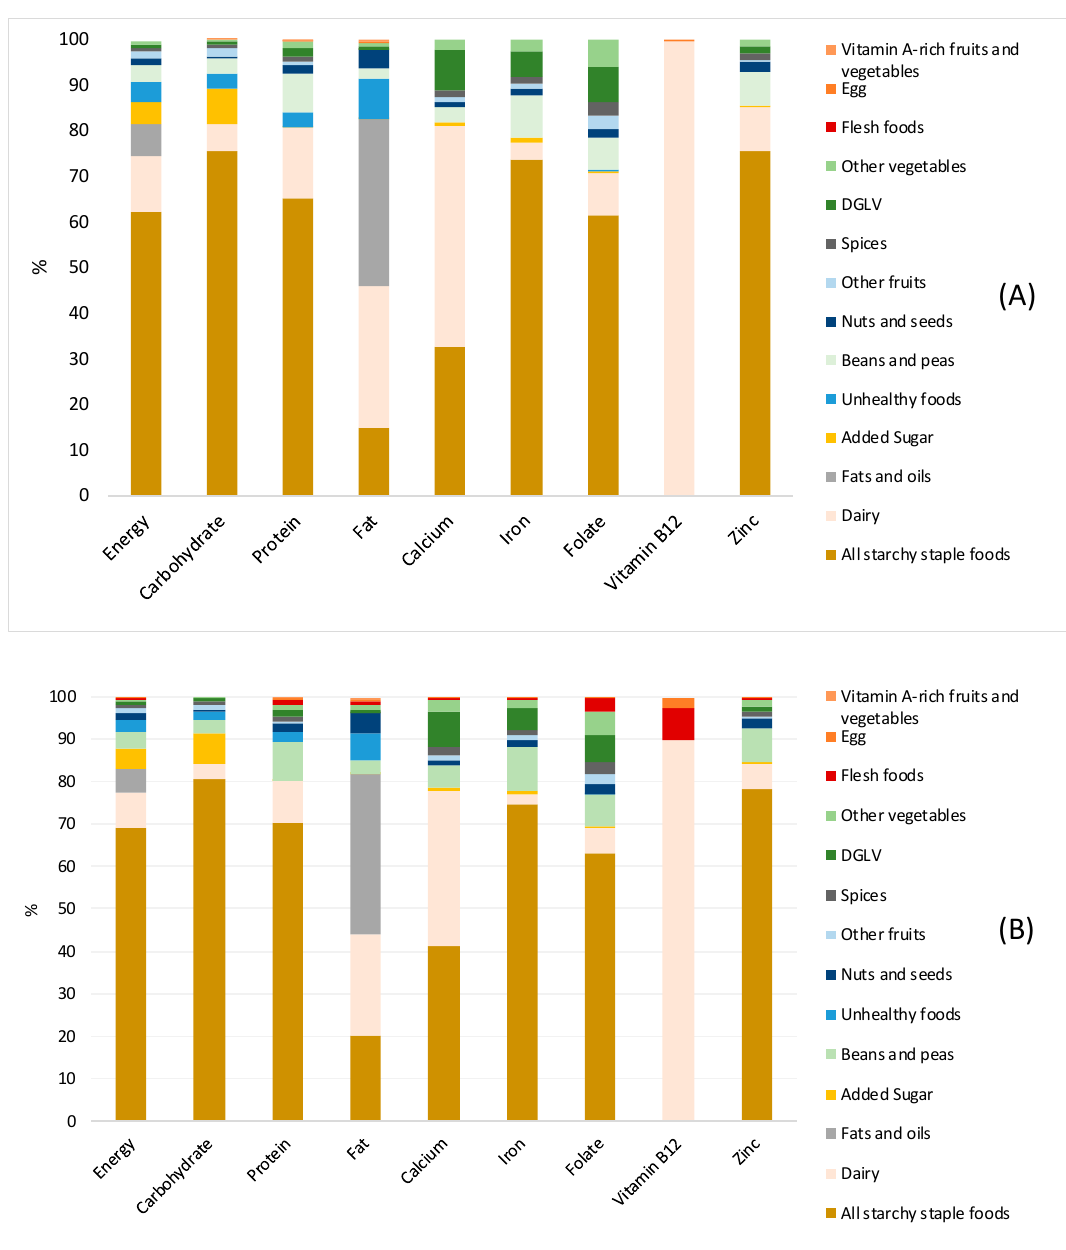
Figure 3. ( A ). Lacto ‐ vegetarians, ( B ). Non ‐ vegetarians. Relative contributions of different food groups